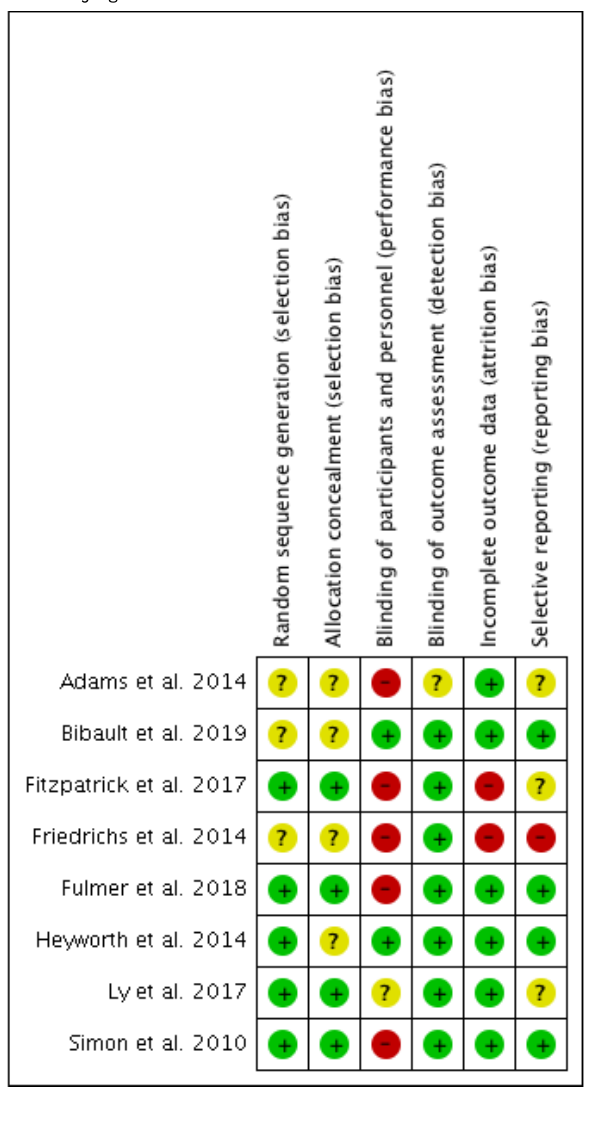
Figure 2. Risk of bias summary: review authors' judgements about each risk of bias item for each included study.